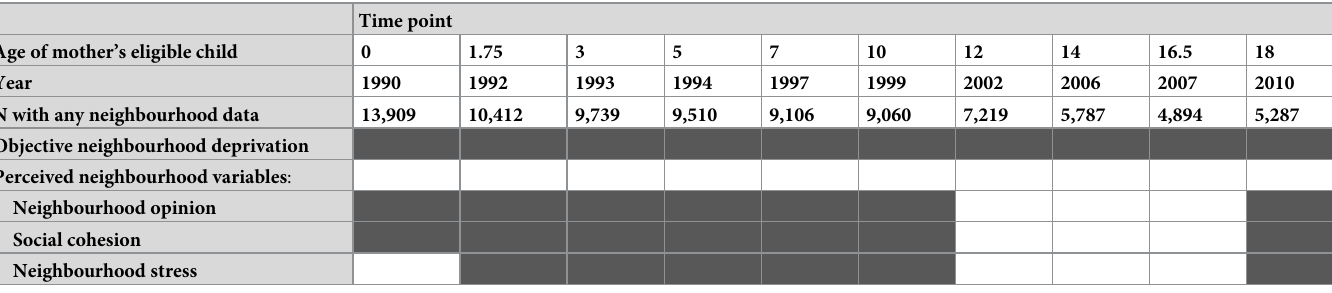
Table 1. Timing of measurement for neighbourhood variables.